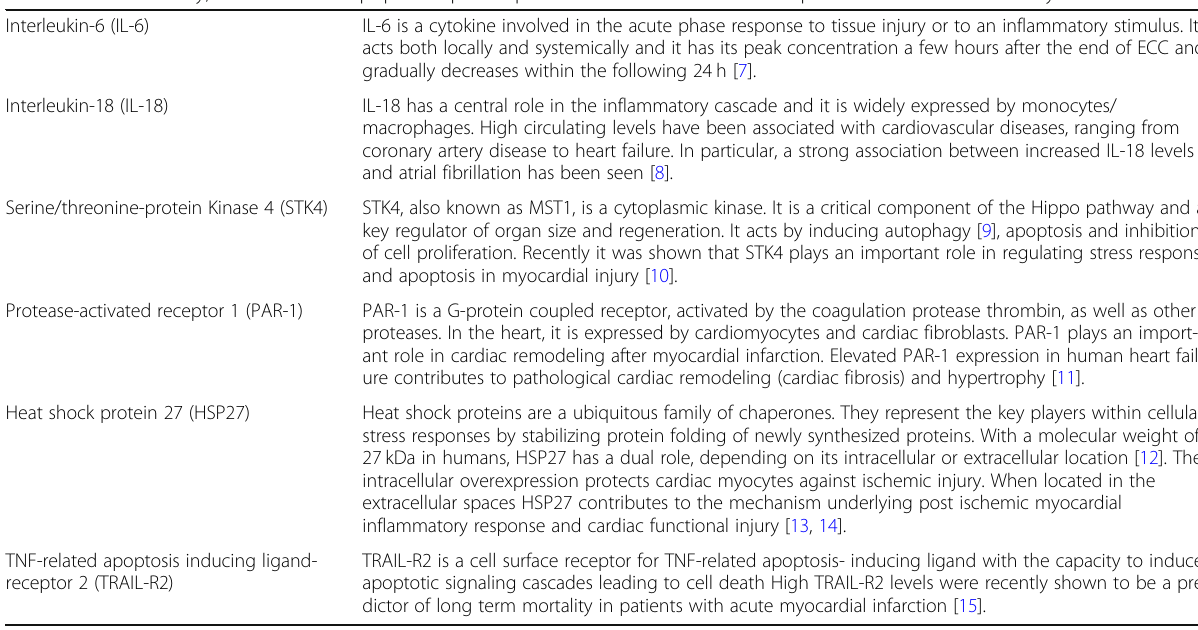
Table 1 Inflammatory, cell stress and apoptosis specific proteins included in the CVD II panel and used in the study Interleukin-6